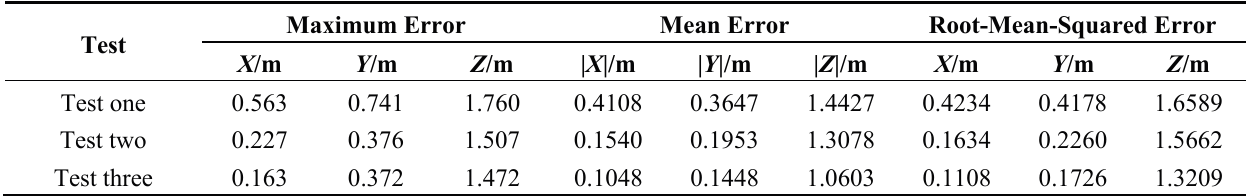
Table 6. Results of the geo-positioning accuracy with bundle block adjustment in the side slope zone of the Jianshan